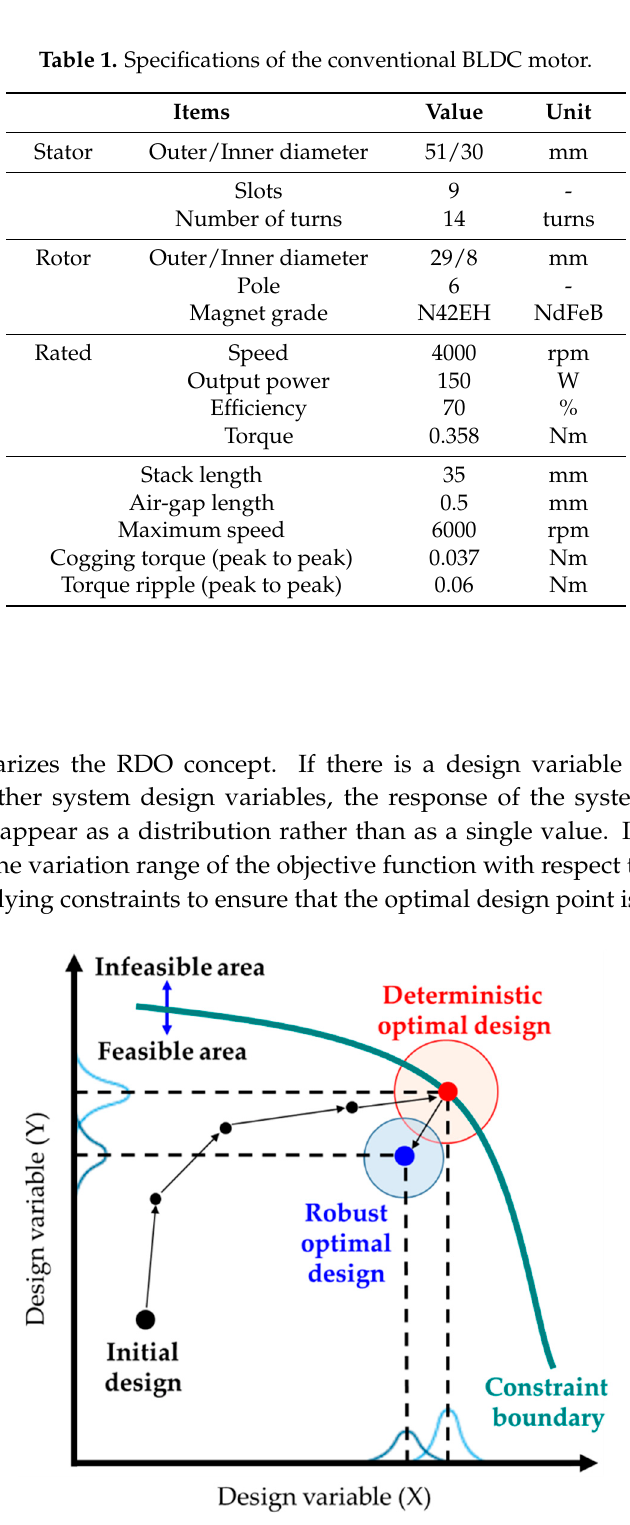
Figure 4. Robust design optimization (RDO) concept.